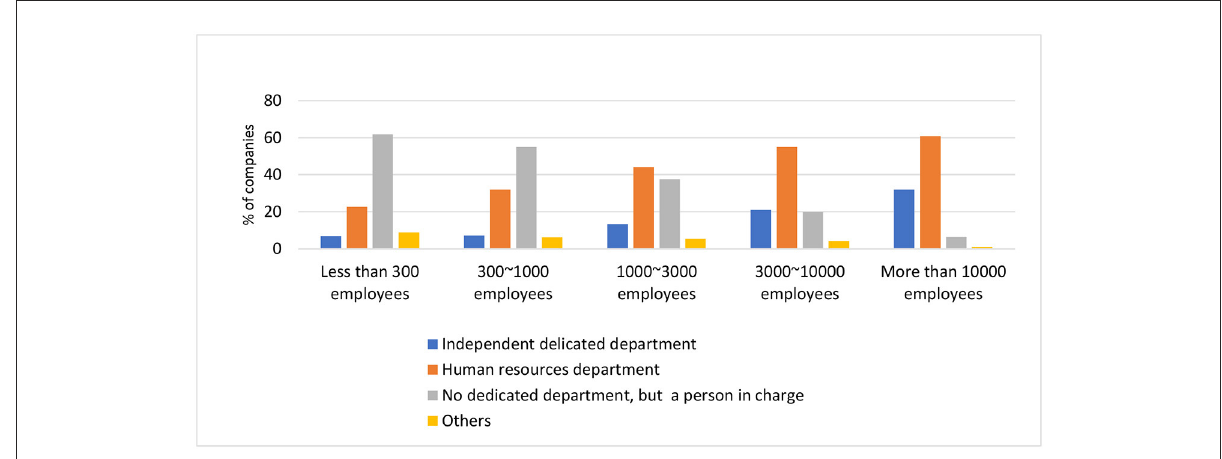
FIGURE5 The department in charge of